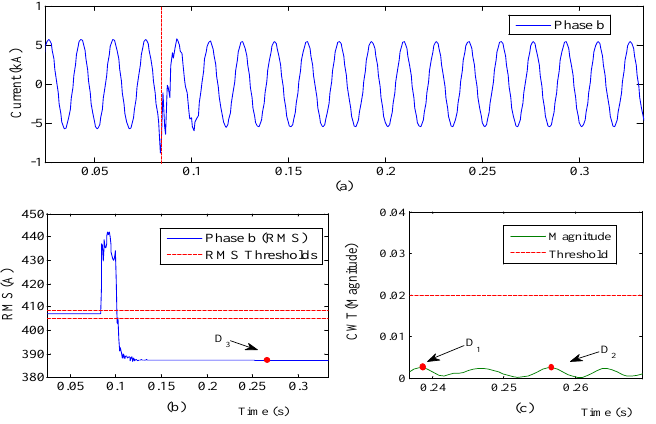
Figure 11. Capacitor bank energization event in (13-Bus) is detected and classified, ( a ) I b ; ( b ) D 3 ; ( c ) D 1 and D 2 of the normalized I n in the 11th–12th